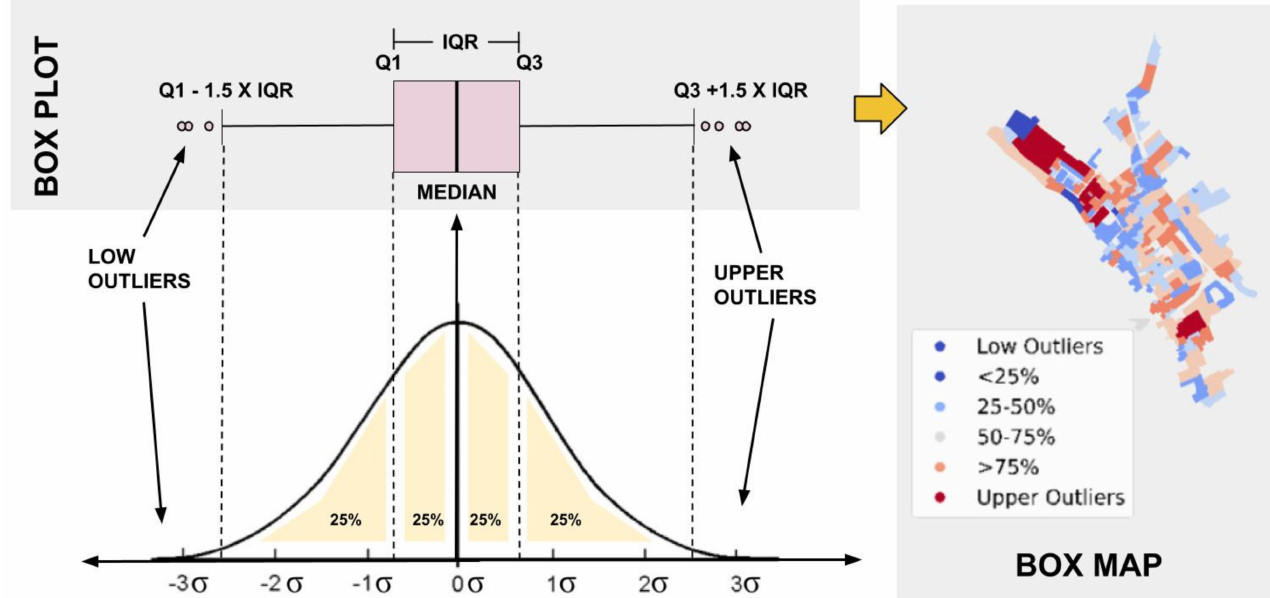
Figure 3. Exemplification of a boxplot based on a probability function of a normal population. This translates into the six bins used for the classification of the data in the box map (lower outliers, <25%, 25–50%, 50–75%, >75% and upper outliers). Q1: first quartile (lower or 25th empirical quartile). Q2: median of the data. Q4: third quartile (upper or 75th empirical quartile). IRQ: interquartile